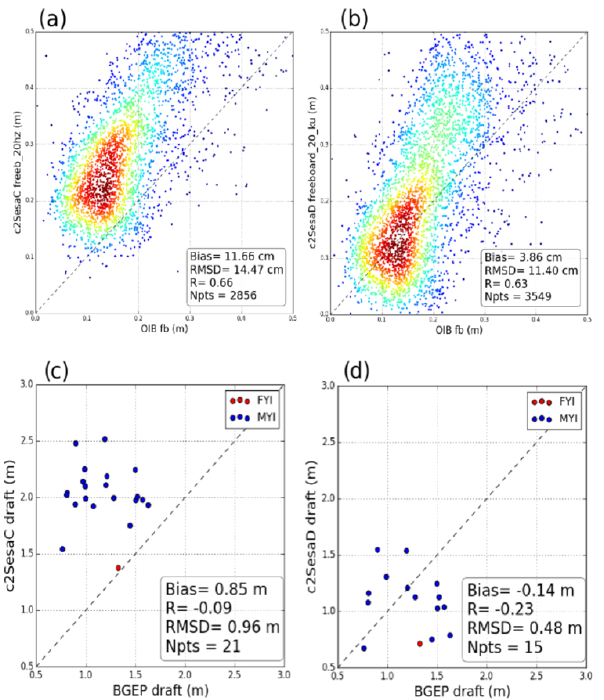
Figure 10. Gridded monthly freeboard from Baseline-C (a–b) and Baseline-D (c–d) L1b data for the period January–February 2014. The dashed red line in (c) represents the boundaries of the SARIn acquisition